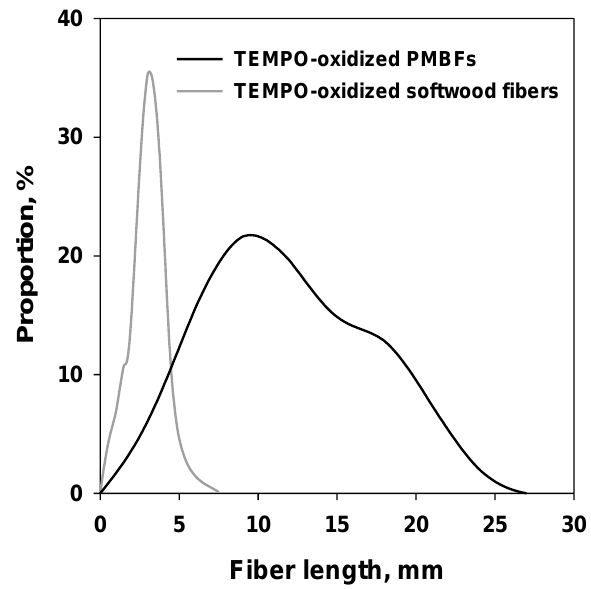
Figure 1. Fiber length distribution of TEMPO-oxidized PMBFs and softwood fibers.